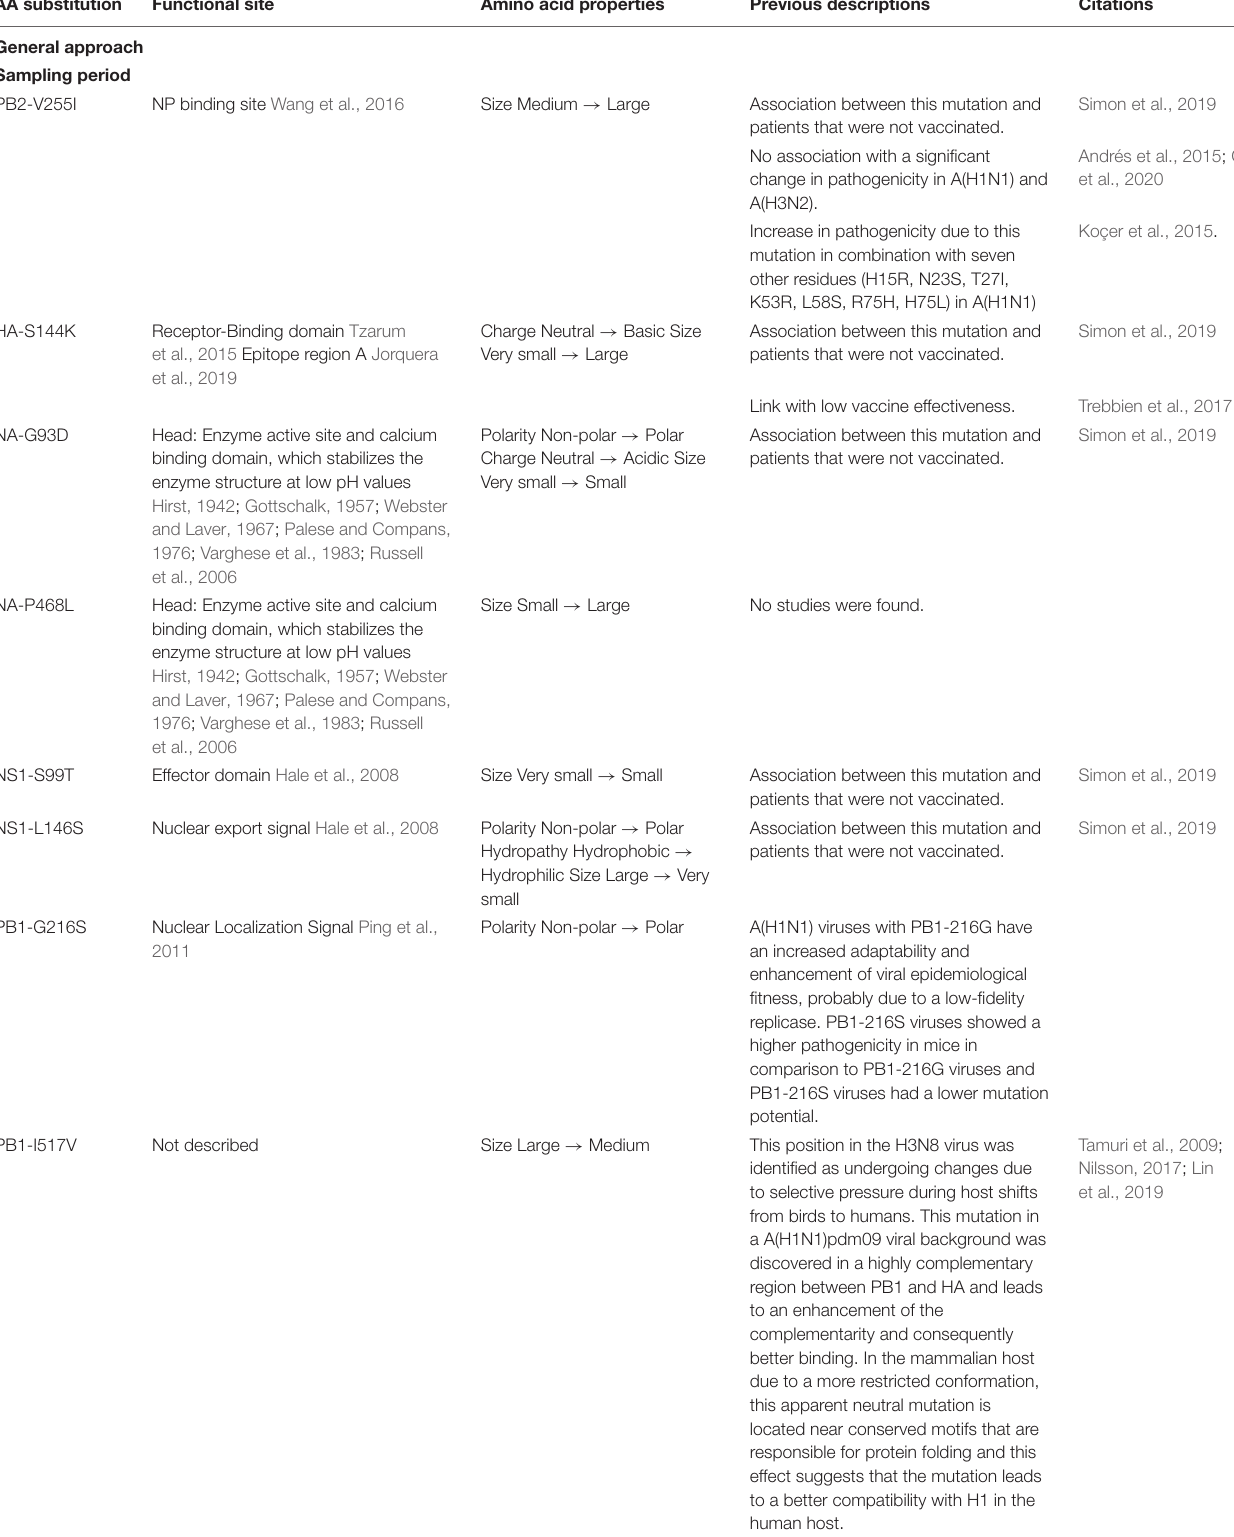
TABLE 2 | Statically significant associations found between patient data and amino acid mutations in the whole